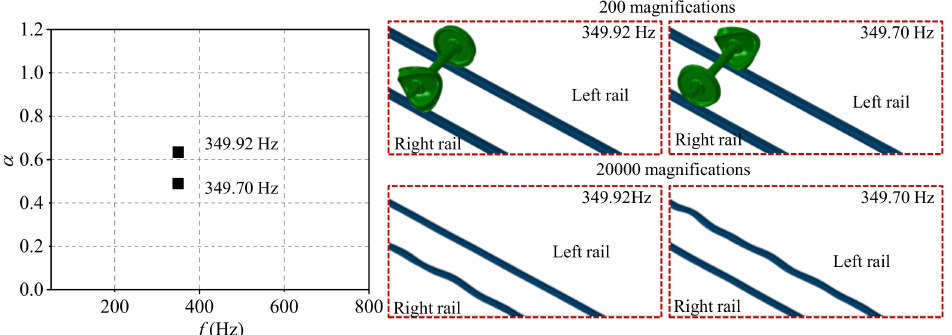
Figure 9. Distribution of real parts of eigenvalues and modal situations of the smooth wheel– corrugated rail system.